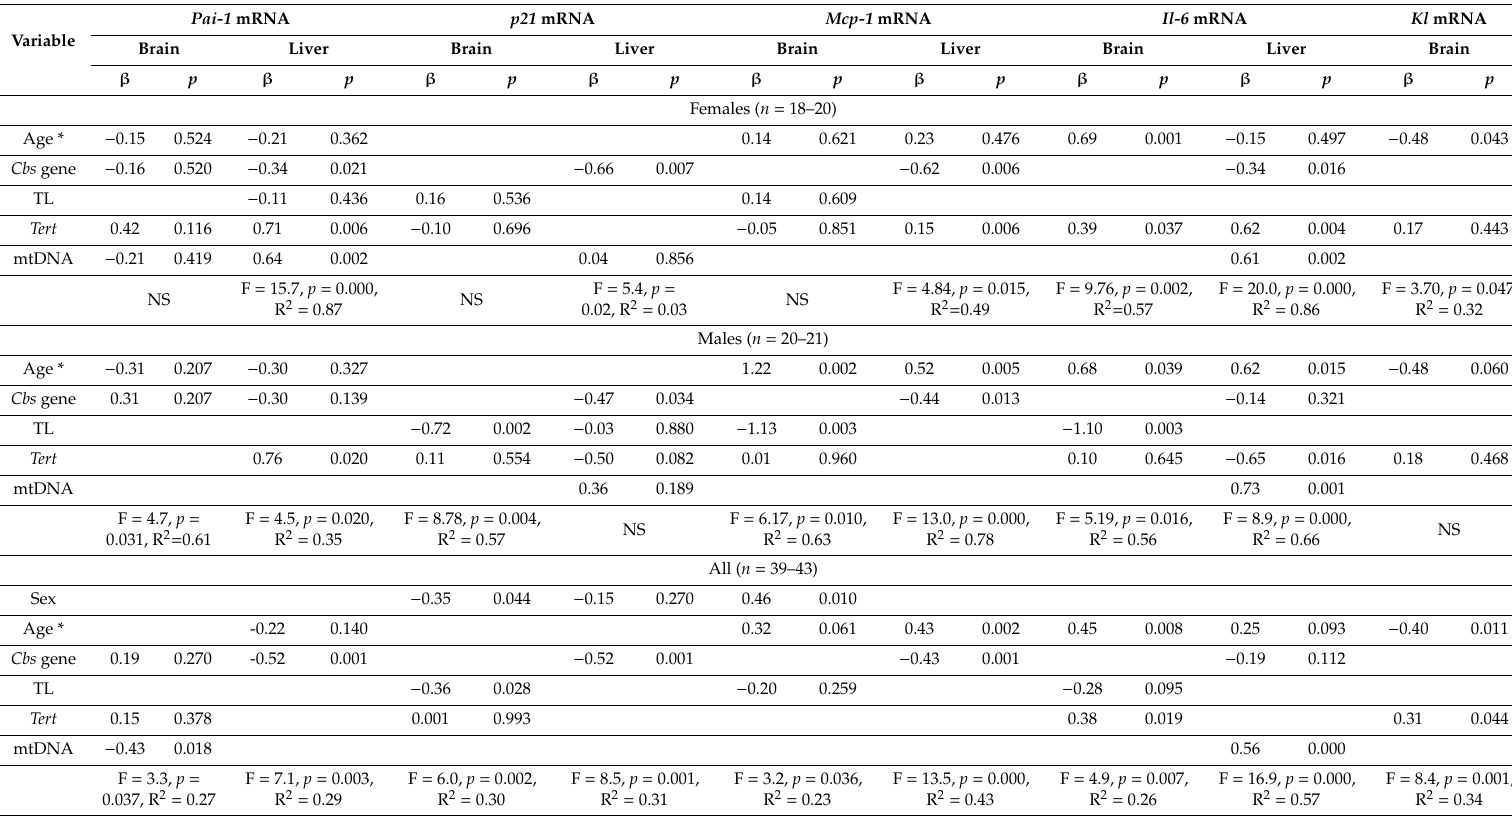
Table 4. Determinants of Pai1 , p21 , Mcp-1 , Il-6 , and Kl mRNAs in brains and livers of Cbs − / − and Cbs +/ − mice: multiple regression